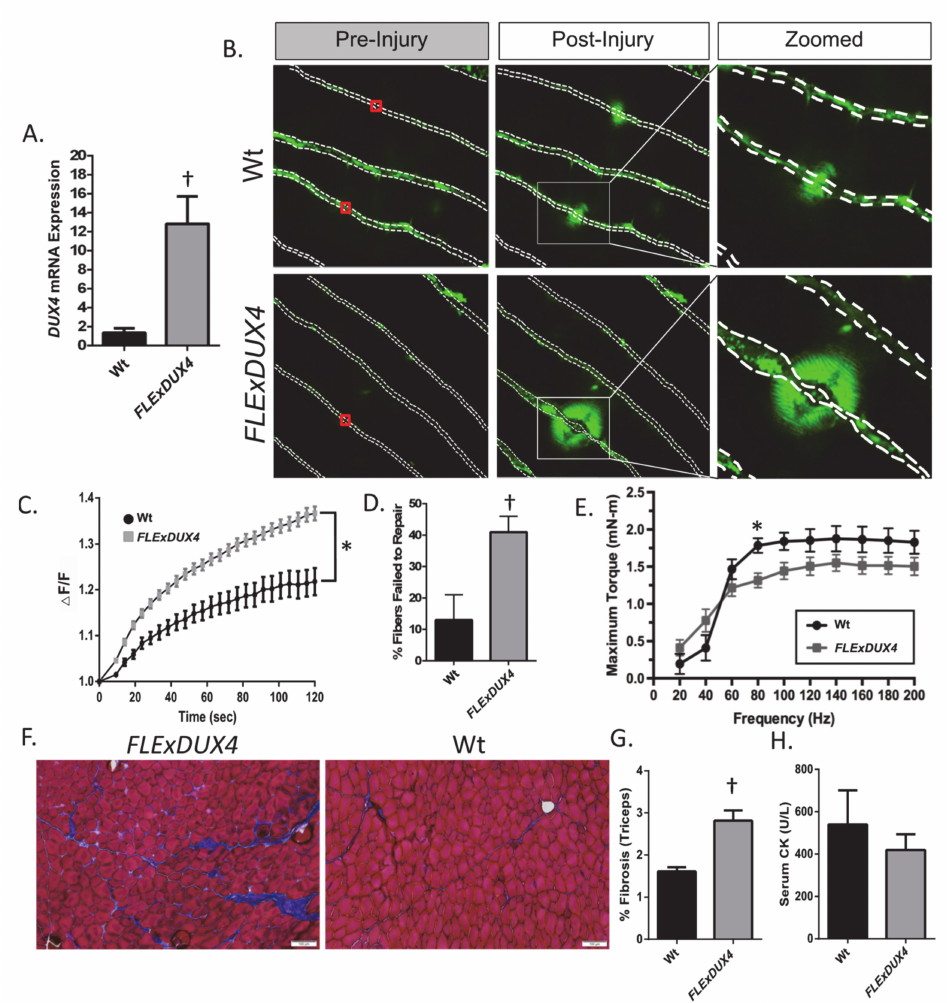
Figure 4. Mature myofibers from FLExDUX4 mice demonstrate sarcolemmal repair deficit. ( A ) DUX4 mRNA relative expression in FLExDUX4 vs. Wt mice. ( B ) Representative images from membrane repair assays in FLExDUX4 ( n = 4) and wild type (Wt, n = 3) mouse biceps. Dotted lines denote the myofiber sarcolemma. Red box denotes site of injury. The extent of dye entry into the fiber (green dye in myofiber interior) is used to determine the kinetics of membrane resealing. ( C ) Mean ± SEM for change in fluorescence intensity of FM1-43 dye entry ( ∆ F / F) into the myofiber after laser injury in FLExDUX4 and Wt mice. ( D ) Percentage of myofibers that failed to repair following membrane injury in FLExDUX4 and Wt mice. ( E ) Force-frequency relationship curve for the tibialis anterior of 6.5-month old male FLExDUX4 ( n = 3) and Wt ( n = 3) mice (significant interaction genotype*frequency, p < 0.05, with a significant di ff erence identified at 80 Hz). ( F ) Masson’s Trichrome staining in the triceps of a FLExDUX4 and a Wt mouse. ( G ) Percentage (of total area) of triceps fibrosis in 6.5 month-old male FLExDUX4 ( n = 5) and Wt ( n = 3) mice. ( H ) Serum creatine kinase (CK) in n = 5 FLExDUX4 (3 male, 2 female) and n = 5 Wt (3 male, 2 female) mice. * indicates significant genotype ( FLExDUX4 vs. Wt)*time interaction for FM1-43 intensity at p < 0.05. † denotes di ff erence between FLExDUX4 and Wt mice, independent t -test, p <